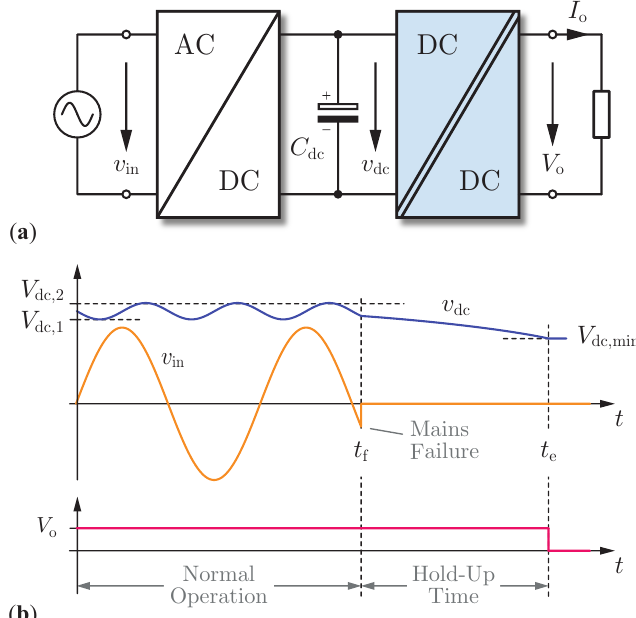
Figure 1. ( a ) Industrial power supply block diagram to convert AC-mains voltage to a high-current V o = 12V output; this work focused on the DC/DC converter. The requirements of the DC- link capacitor ( C dc ) are driven by the hold-up time requirements (here, t e fault conditions, as shown in ( b ). Even with the input voltage range specified here ( V dc,min = V dc,2 = 430V), the DC-link capacitor accounts for nearly 15% of the allocated system 300V − volume, indicating how critical this wide input range for the DC/DC converter is to overall system power